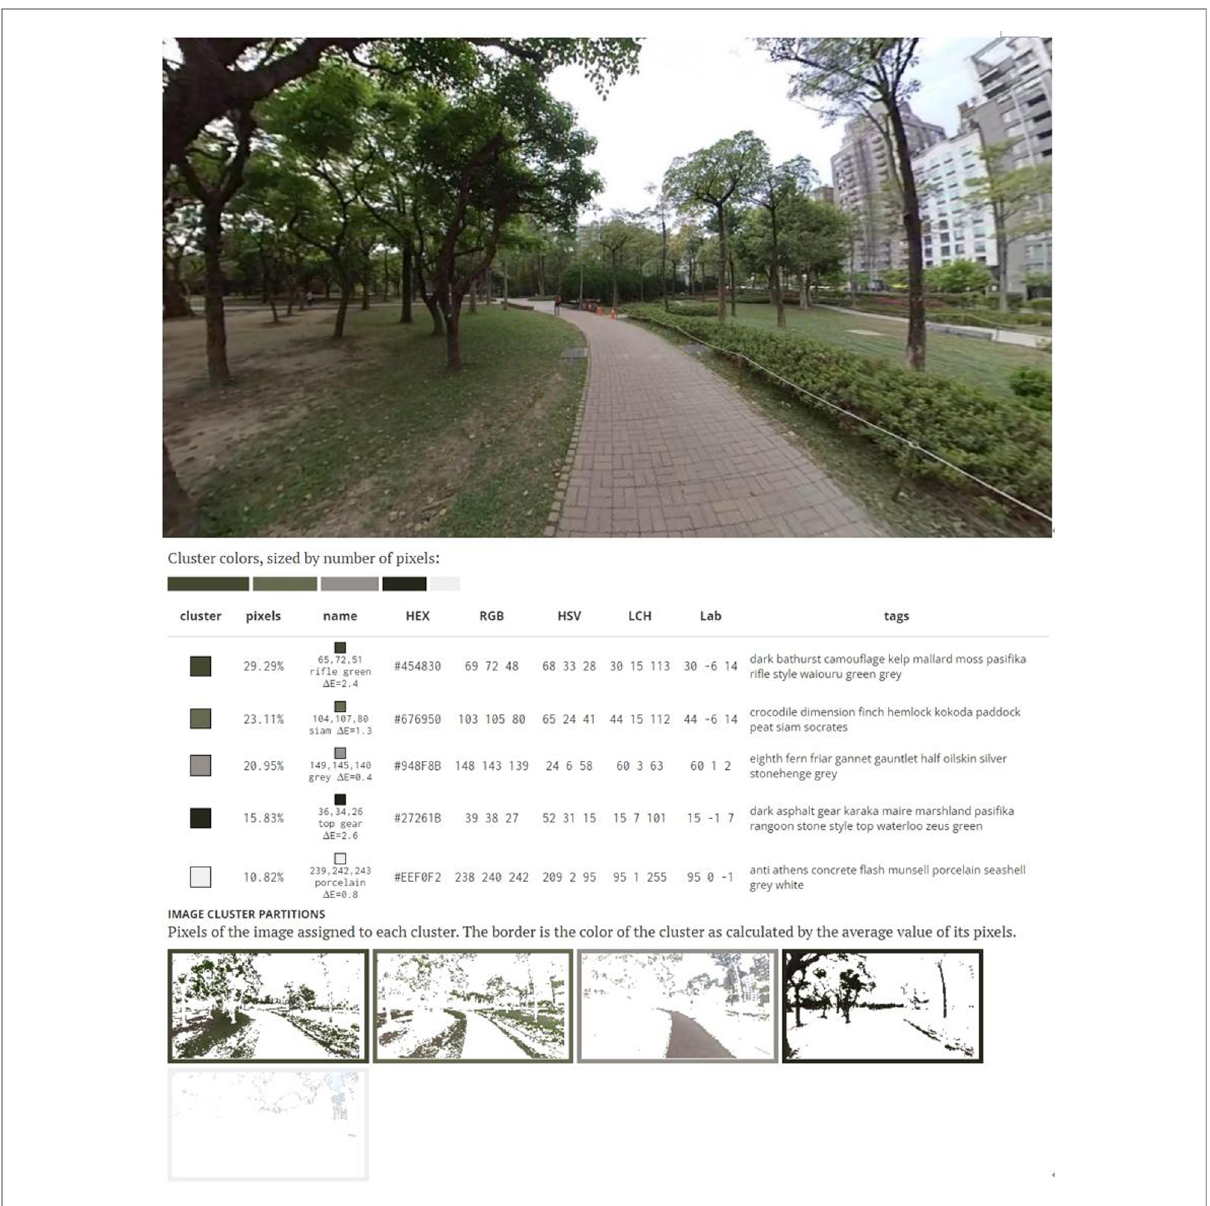
FIGURE 4 Outdoor walking environment colour analysis